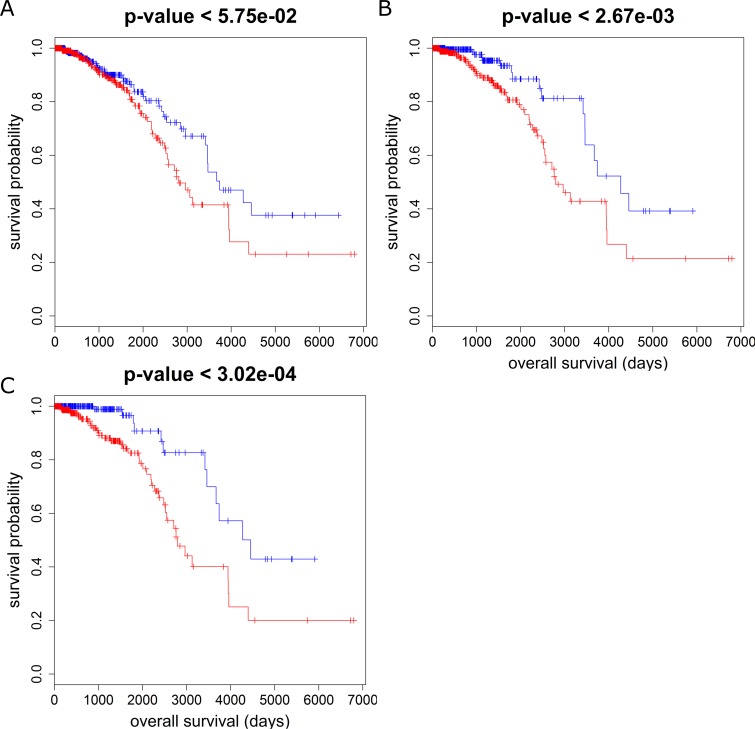
Kaplan-Meier plots of the subgroups defined by median expression of ROPN1 in A) all the patients, B) the ER+ patients and C) the PR+ patients.Blue and red curves correspond to the lower and higher expression levels of ROPN1, respectively.